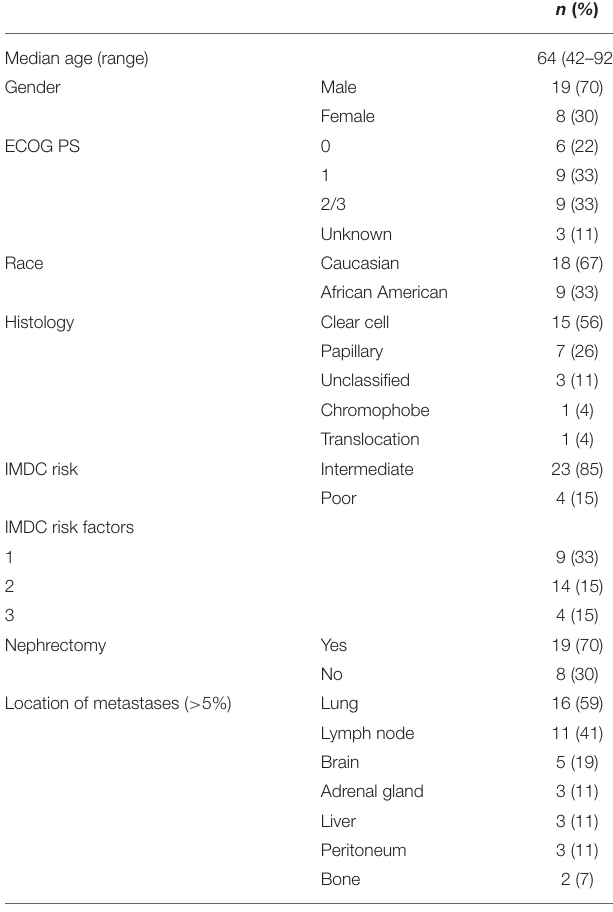
TABLE 1 | Baseline characteristics of the study cohort ( n =